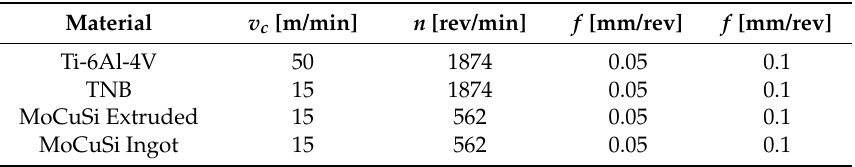
Table 2. Machining conditions for the 8.5 mm hole.